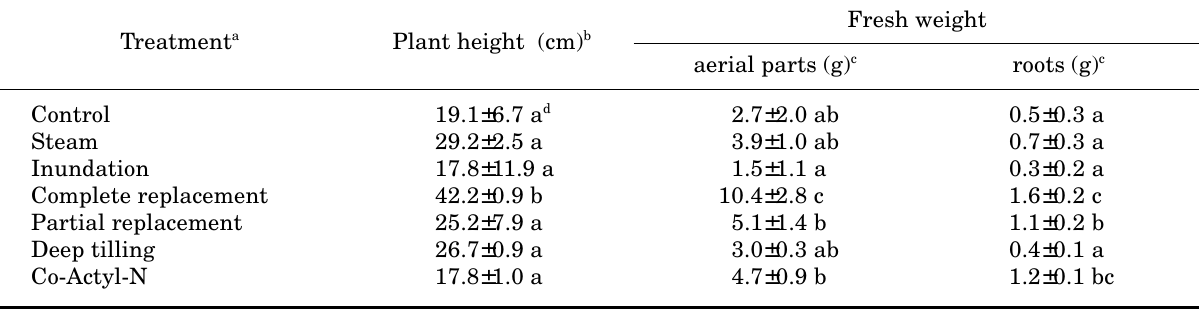
Table 3. Effect of various soil treatments on “stanchezza” (soil sickness) of sweet basil. Results are expressed as plant height and f wt of the roots and aerial plant organs 60 days after sowing on April 4, 1996 (Trial 3, first